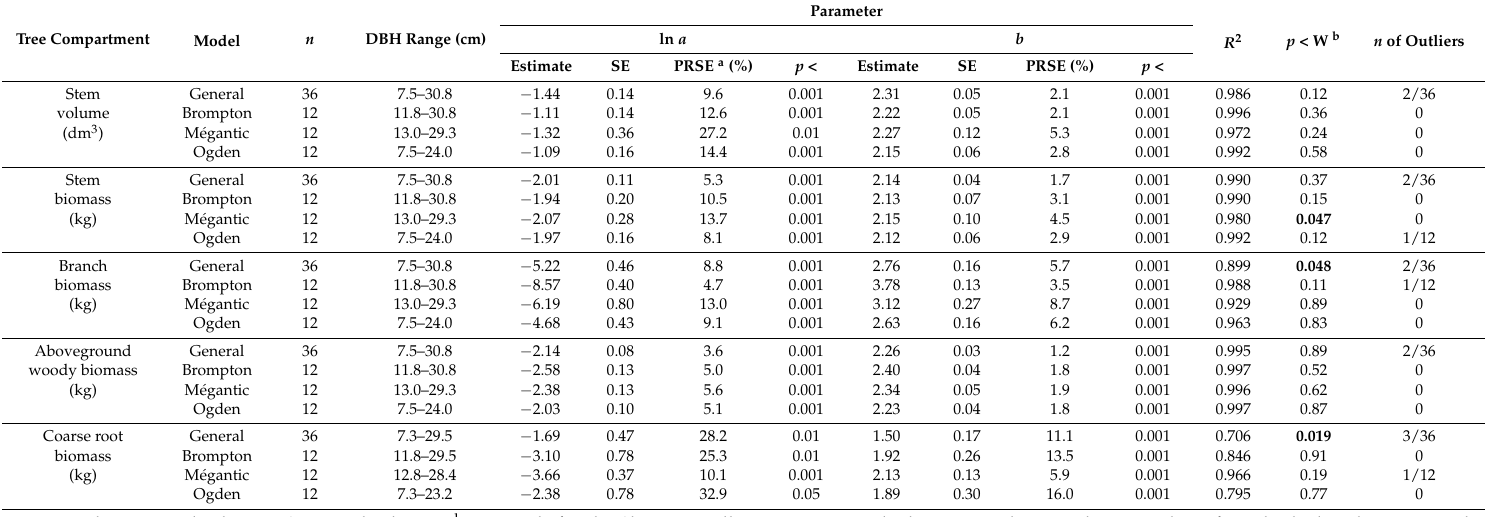
Table 3. Parameter estimates and statistics of general and site-specific allometric relationships between DBH (cm), as a predictor variable, and the volume or biomass of different tree compartments as response variables. All equations are in the form of ln ( y ) = ln a + b ln ( x ), where x is DBH and y is the volume or biomass of the tree